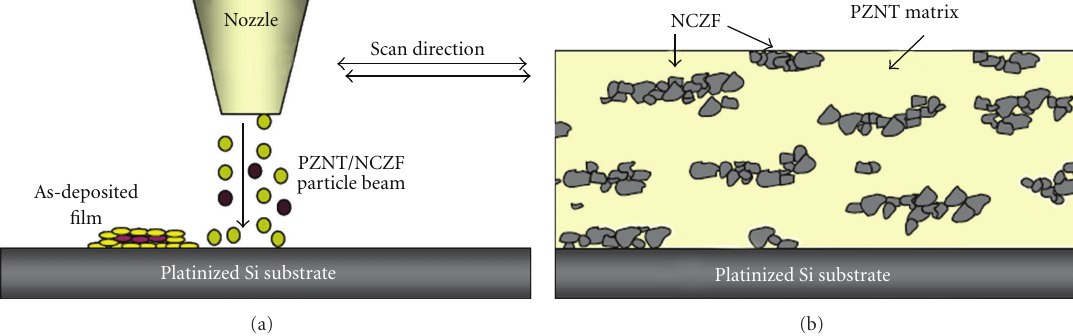
Figure 5: Schematic illustration of (a) ME composite film fabrication and (b) microstructure of nanocomposite ME films by AD, [75].